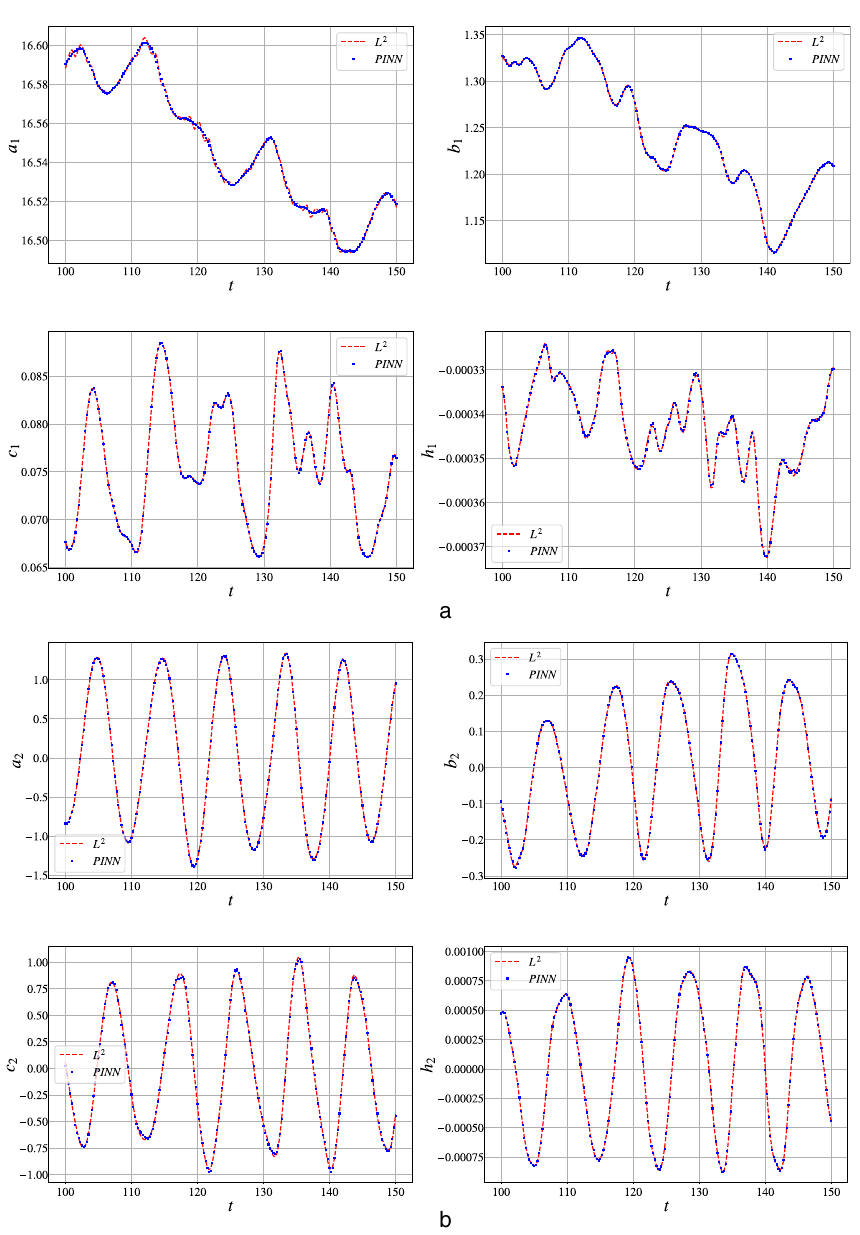
Fig. 15 The results of the PINNs predictions for all reduced variables, the reduced order spaces are constructed with N u = N p = N S = 60. The plots compare the reduced coefficients with the L 2 projection coefficients. The red-dashed lines refers to the L 2 projection coefficients, while the blue-dots correspond to the reduced coefficients obtained by the PINNs. (a) The first reduced coefficients for velocity, pressure, turbulent and convective terms compared to the ones obtained by the L 2 projection. (b) The second reduced coefficients for velocity, pressure, turbulent and convective terms compared to the ones obtained by the L 2